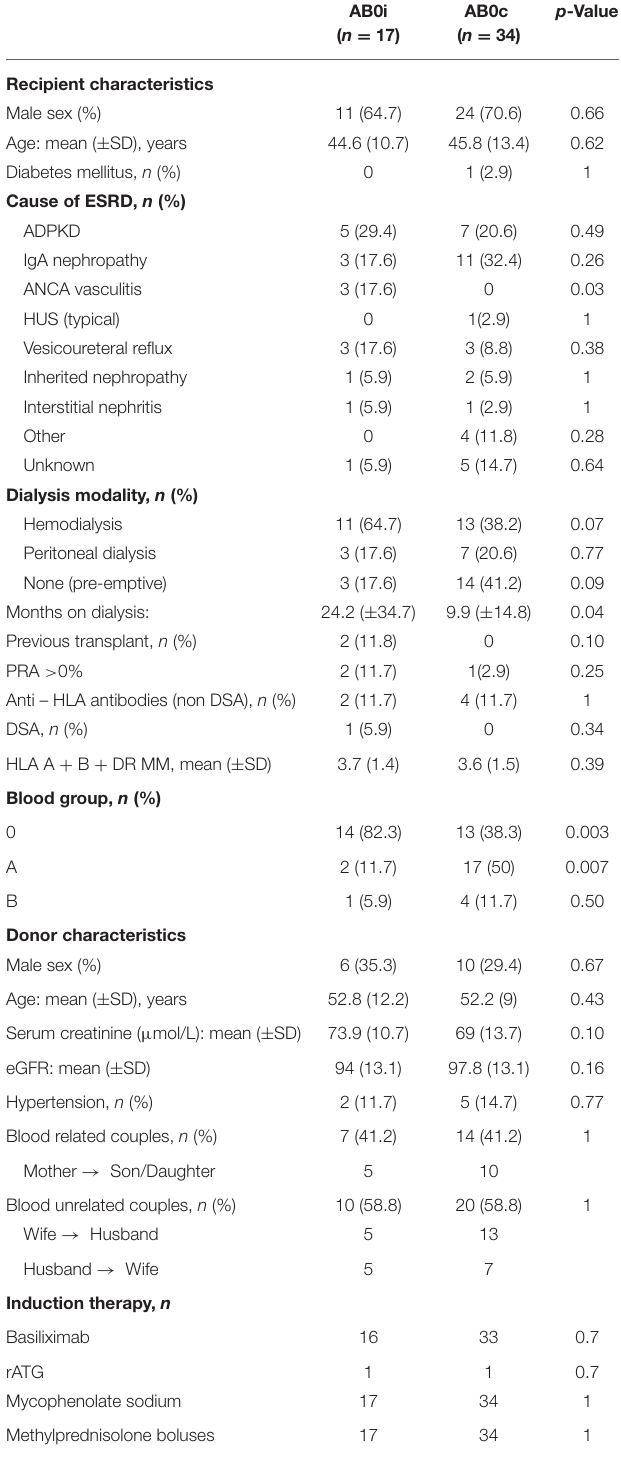
TABLE 1 | Baseline characteristics of recipients and donors in AB0i and AB0c